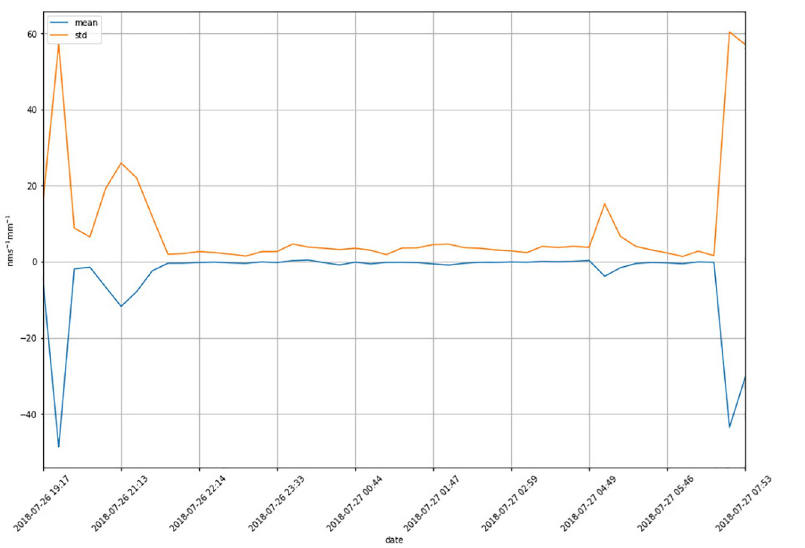
Fig 5. The mean and std of the elongation rates of the seedling